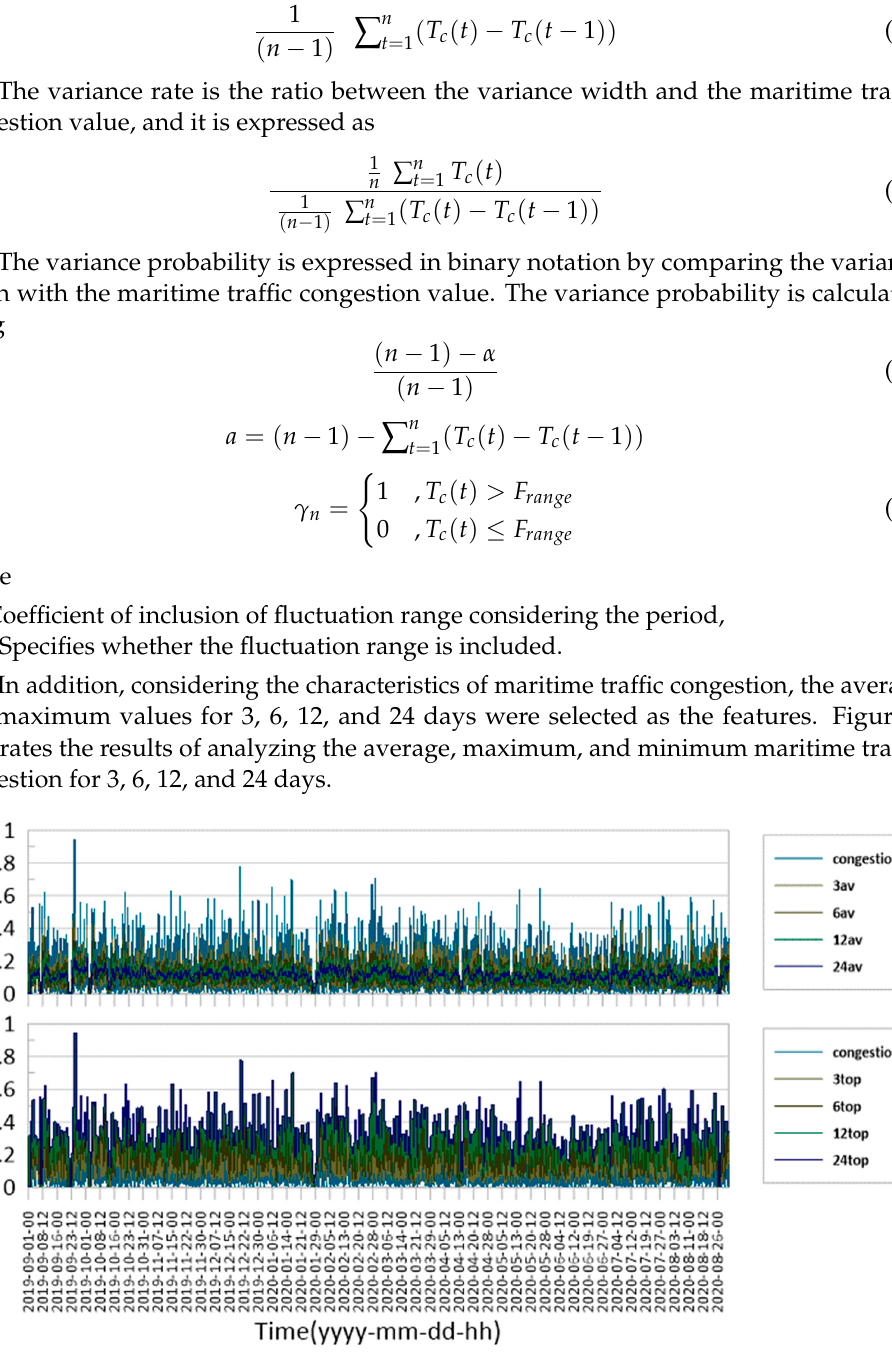
Figure 5. Average/maximum/minimum maritime traffic congestion (days 3, 6, 12, and 24).